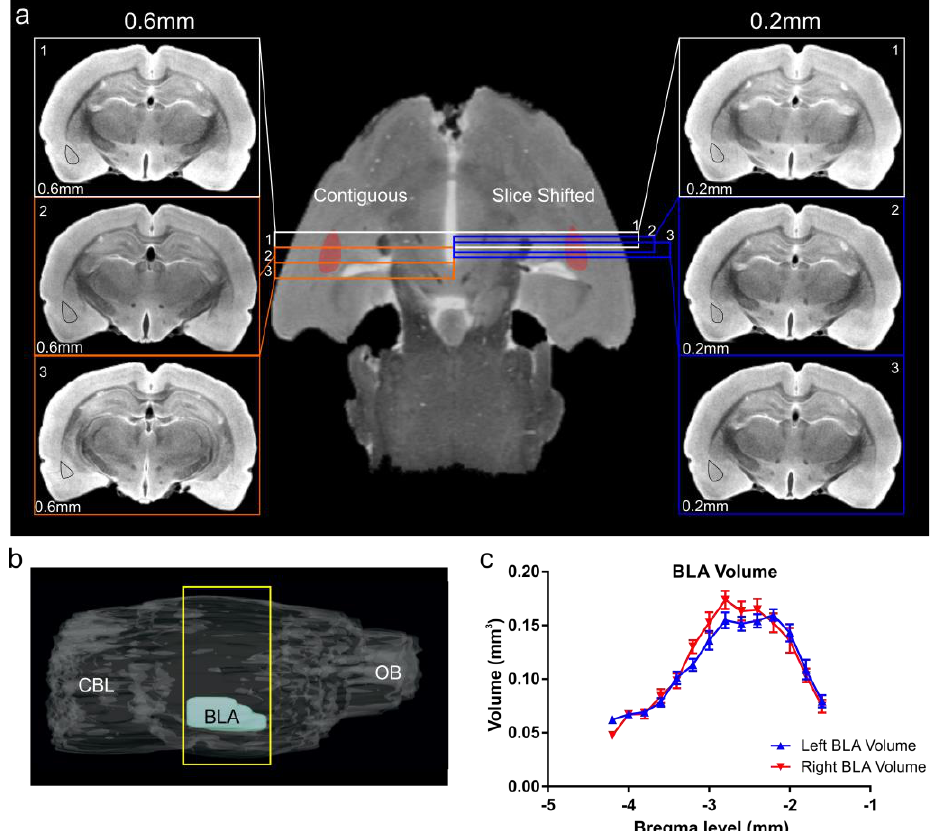
Figure 4. Basolateral amygdala volumes derived using a slice-shifting approach. ( a ) Conventional sequential DTI of the rat brain utilized a slice thickness (contiguous) of 0.6 mm for optimal signal to noise/contrast to noise (SNR/CNR). Thus, with this acquisition method small anatomical structures, such as the BLA, only 2 – 3 slices capture the volume of the BLA (left-hand panel, slice thickness 0.6 mm, isodistance between slices = 0.6 mm, left BLA region outlined in black). In contrast, a slice-shifting technique that retained the same slice thickness (for optimal SNR/CNR) but captured a series of slices through the BLA at different isodistances with offsets of 0.2 mm (right-hand panel, slice thickness 0.6 mm, isodistance between slices = 0.2 mm) provided 6 – 9 slices encompassing the BLA. Using slice-shifting, the small area of the basolateral complex of the amygdala is captured in a greater number of slices for accurate volumetric analysis. ( b ) Sagittal MRI view of the rat brain illustrating the region encompassed by the BLA (yellow rectangle) from which DTI data were obtained. CBL — cerebellum, OB — olfactory bulb. ( c ) The slice shifting method yields an average BLA volume in an anterior – posterior direction that is similar between right and left BLA volumes and concur with the histology and volumes reported in the literature (see Figure 5). (See Supplementary Figure S3).